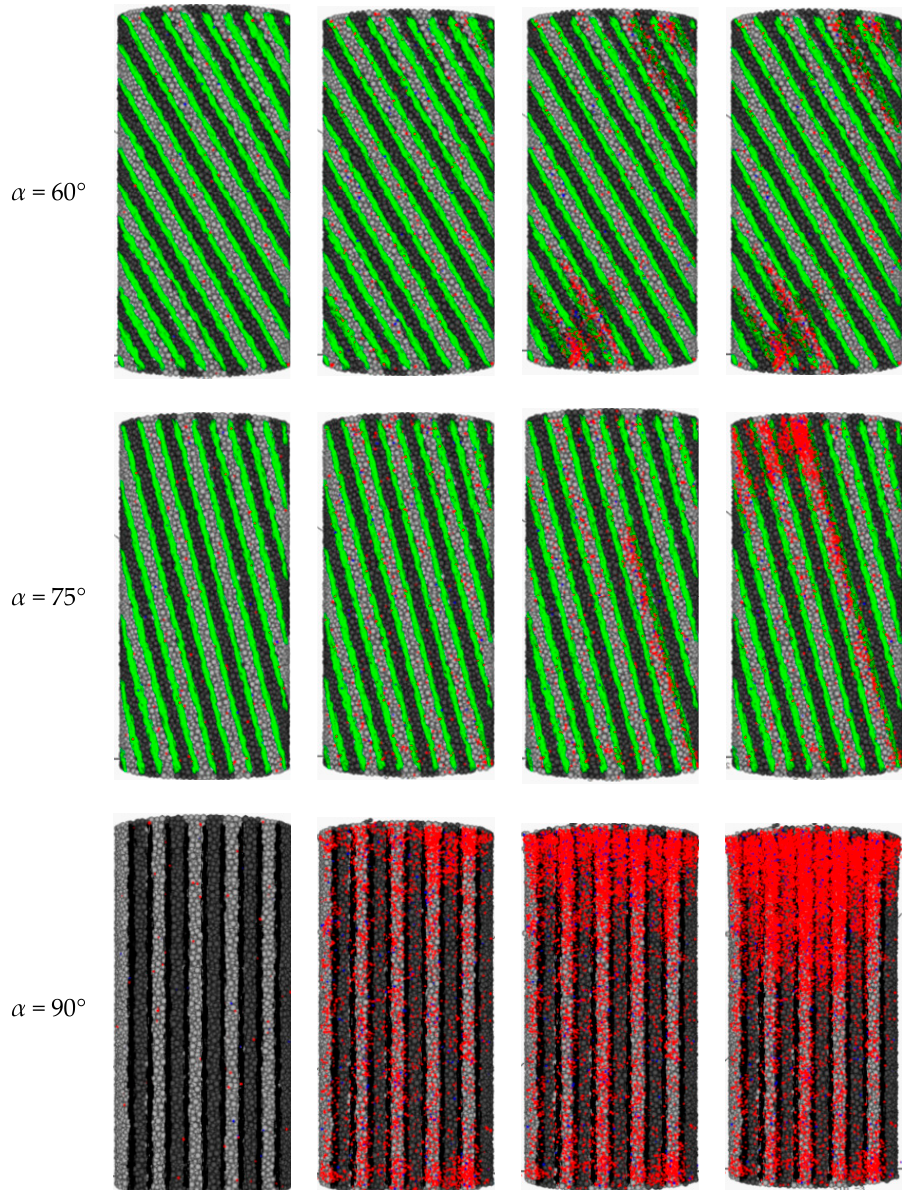
Figure 7. Failure process of transversely isotropic jointed rock models.